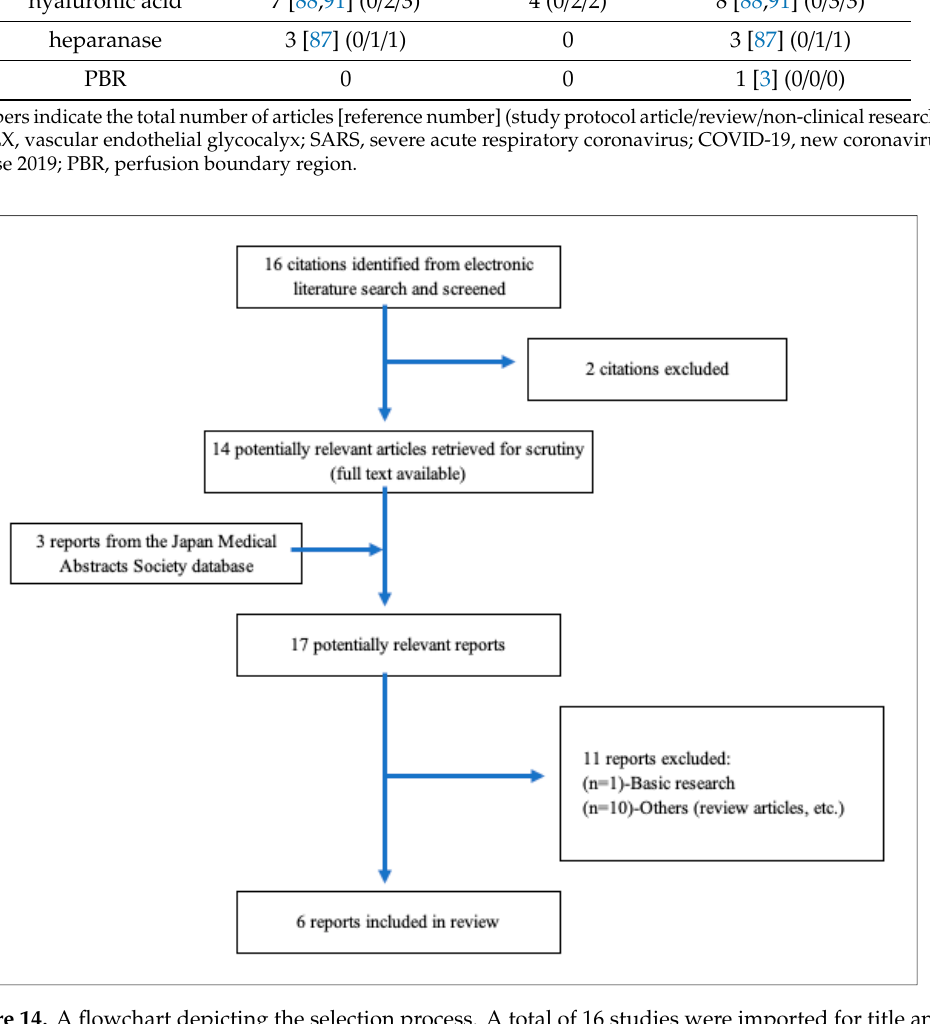
Figure 14. A flowchart depicting the selection process. A total of 16 studies were imported for title and abstract screening after removing duplicates, and 2 studies were retained. After a total of 11